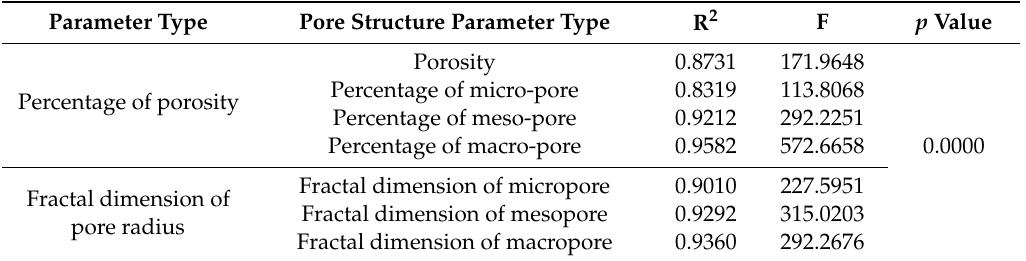
compressive strength.